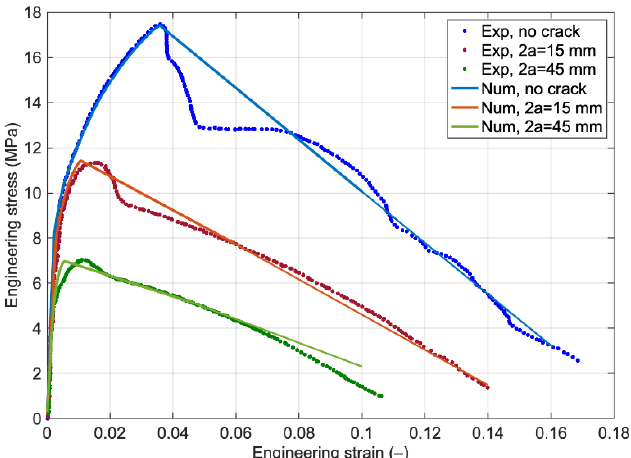
Figure 3. Comparison of the engineering stress-strain curve of plain and notched laminates obtained by experimental test and numerical methods using interface layer.